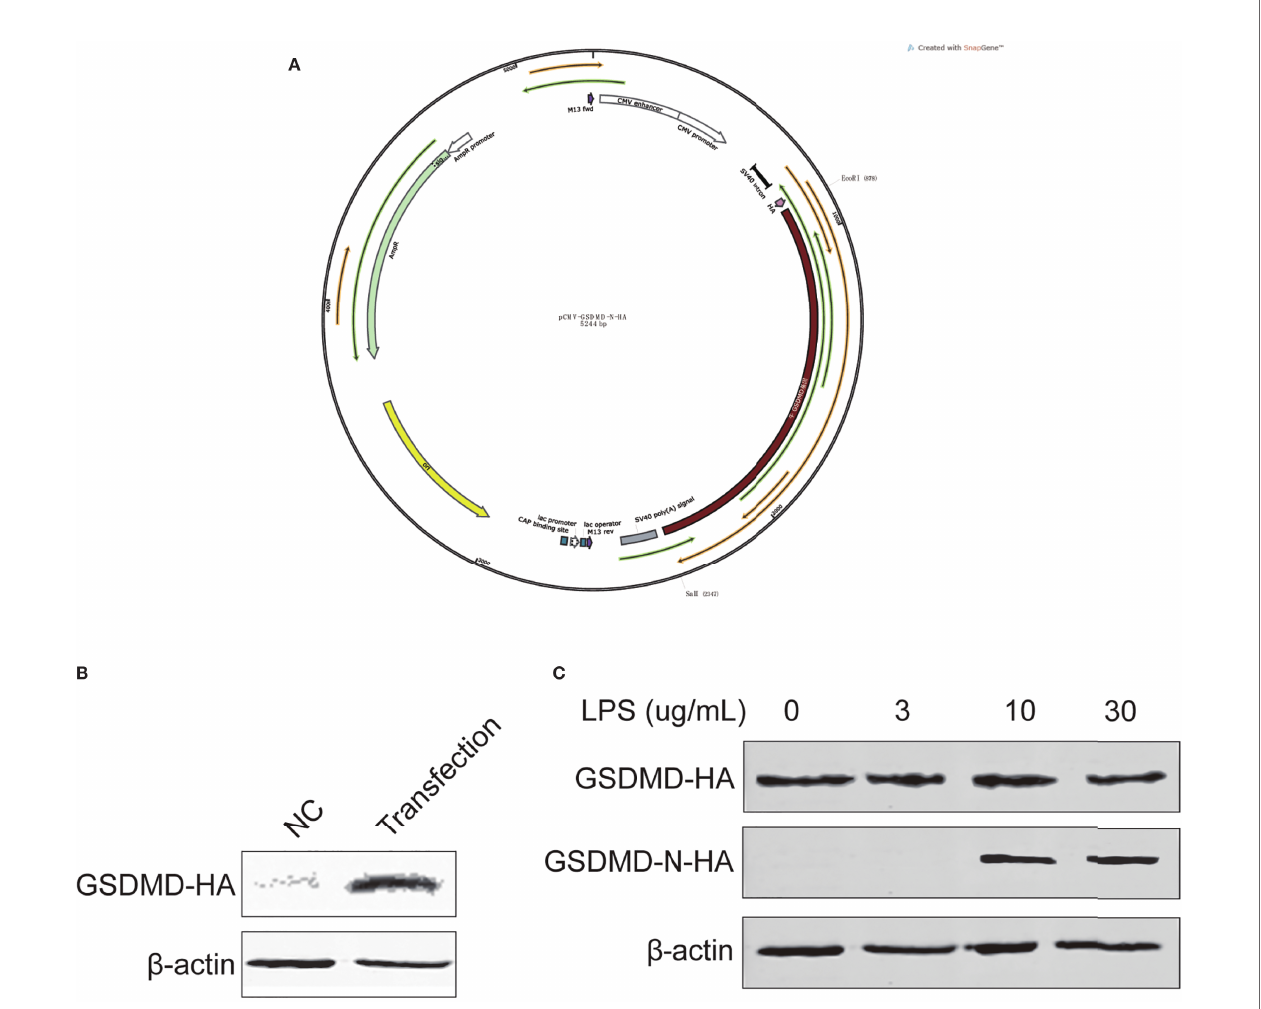
FIGURE 6 | Vector construction, transfection. GSDMD and cleaved N-terminal protein expression of cells treated with different concentrations of LPS for 24 h. (A) the vector, (B) vector transfection, and (C) GSDMD and cleaved N-terminal. Each treatment had three samples (n = 3) and was repeated three times to reduce system